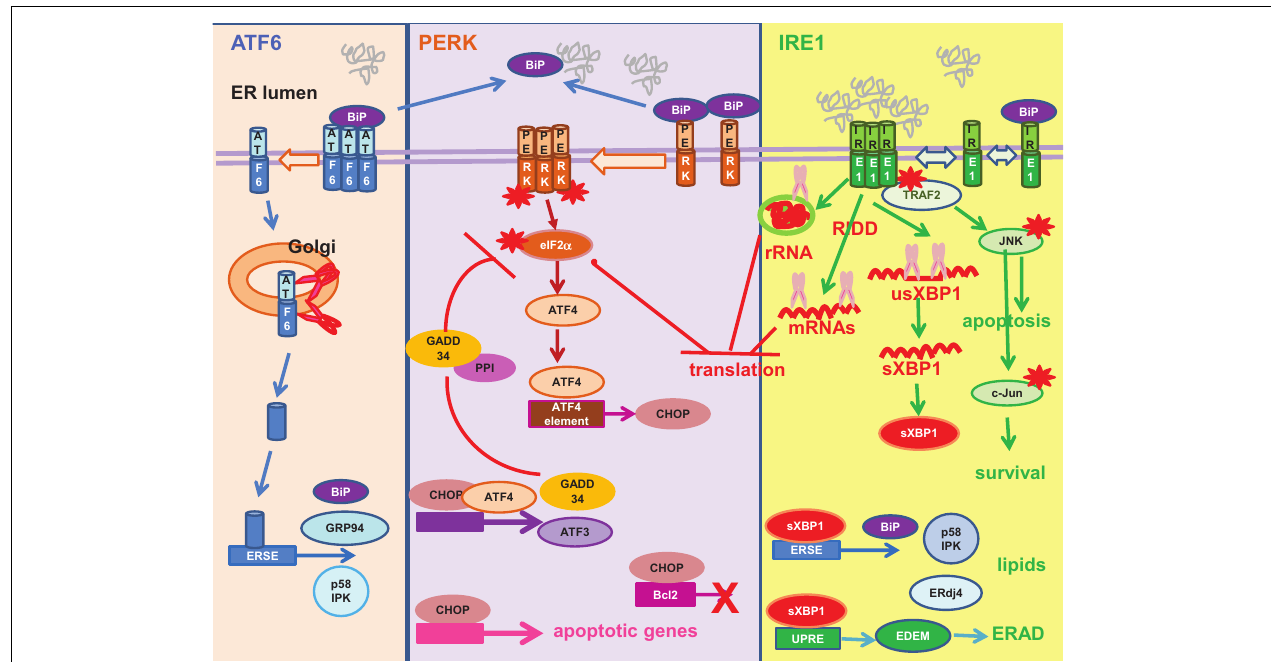
FIGURE 3 | Unfolded protein response. Mammalian unfolded protein response (UPR) is a tripartite response involving three proximal sensors: activatingfactor(ATF)6,RNA-dependentproteinkinase-likeER-residentkinase (PERK) and inositol-requiring enzyme 1 (IRE1). Left: ATF6 is sequestered in an inactive state by the molecular chaperone the immunoglobulin heavy-chain binding protein (BiP). Unfolded/malfolded proteins “distract” BiP from ATF6. ATF6 de-oligomerizes and migrates to the Golgi, where the monomer is cleaved by site-1 and site-2 proteases (red scissor) into an active transcription factor. The truncated N-terminal ATF6 is translocated to the nucleus where it transactivates UPR genes harboring an ERSE in their promoters e.g., BiP, glucose-regulated protein 94 (GRP94), P58 IPK . Middle: PERK is sequestered in an inactive state by BiP. Unfolded/malfolded proteins “distract” BiP from PERK, allowing its oligomerization and auto-phosphorylation (red asterisk). The activated PERK then phosphorylates its substrate, the alpha subunit of the eukaryotic initiation factor 2 (eIF2 α ) (red asterisk) to inhibit global protein synthesis. Paradoxically, translation of ATF4 is upregulated to drive transcription of UPR genes with an ATF4 element in their promoters e.g., the CCAAT/enhancer-binding protein-homologous protein (CHOP). CHOP is a pro-apoptotic transcription factor, as it transactivates a number of apoptotic genes and downregulates the anti-apoptotic Bcl-2. ATF4 co-operates with CHOP to transactivate ATF3 and the growth arrest and DNA